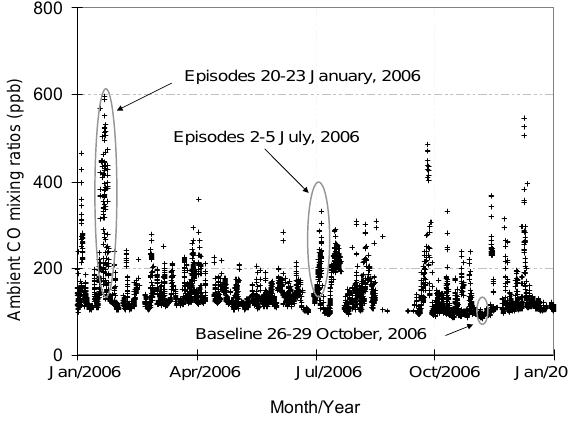
Fig. 7. Hourly data of ambient CO for the whole year of